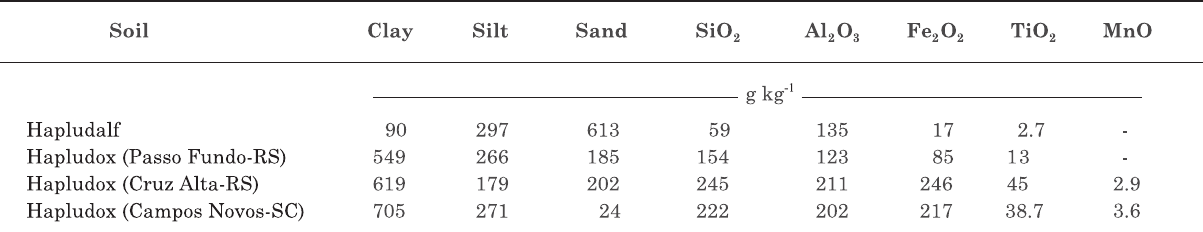
Table 1. Granulometric and mineralogical composition of the studied soils (Taken from Brasil, 1973 and Embrapa,